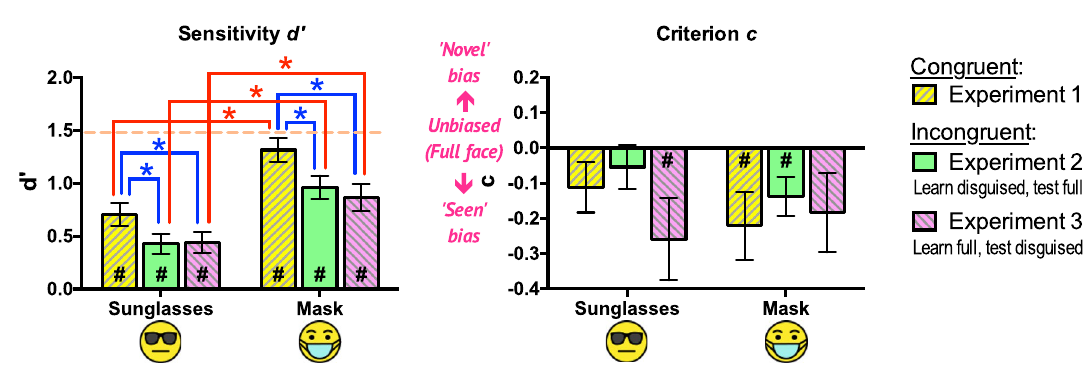
Figure 5. Sensitivities d’ and criteria c (indicating response biases) across the three experiments. Sensitivities: Incongruent disguises (Experiments 2 & 3) led to significantly lower d’ than congruent disguises (Experiment 1), and sunglasses led to significantly lower d’ than masks, as indicated by the asterisks (*). Broken line (in orange): d’ for presenting only full faces, averaged across all three experiments. Criteria: No significant effects were found between sunglasses and masks, and among congruent and incongruent conditions. Presenting only full faces resulted in no significant bias (mean c = – 0.01, p = 0.81; not drawn). All error bars represent ± 1 SEM. The hash signs (#) represent significant differences from zero in the indicated conditions. The unmarked bars and comparisons were not statistically significant. The significance level was set at